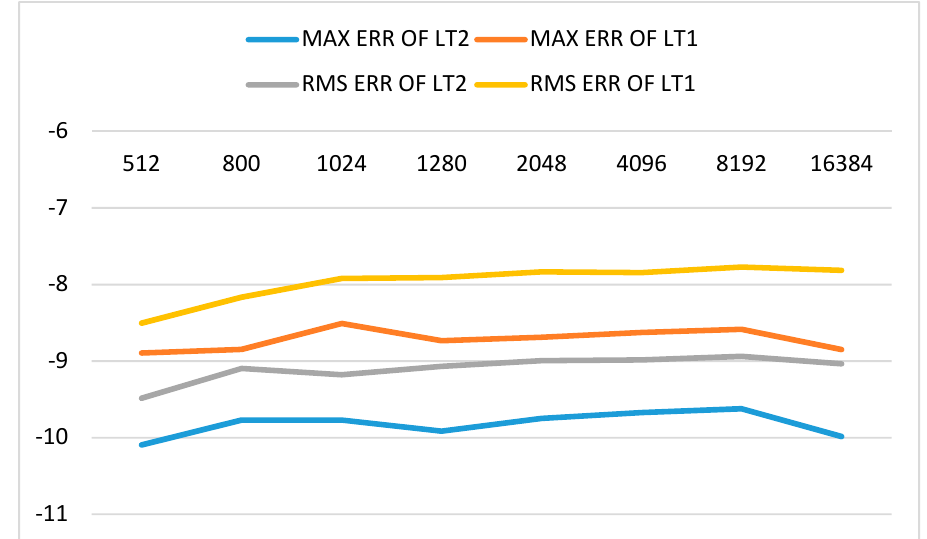
Figure 4. Errors of LT in log10 form with EPS = 1.0E-07 and CMAX = 64 (LT1 is the butterfly algorithm and LT2 is the proposed method. Abbreviations “MAX ERR” and “RMS ERR” denote the maximum error and root-mean-square error, respectively. EPS is desired precision in interpolative decomposition, CMAX is the number of columns in each sub-matrix on level 0).